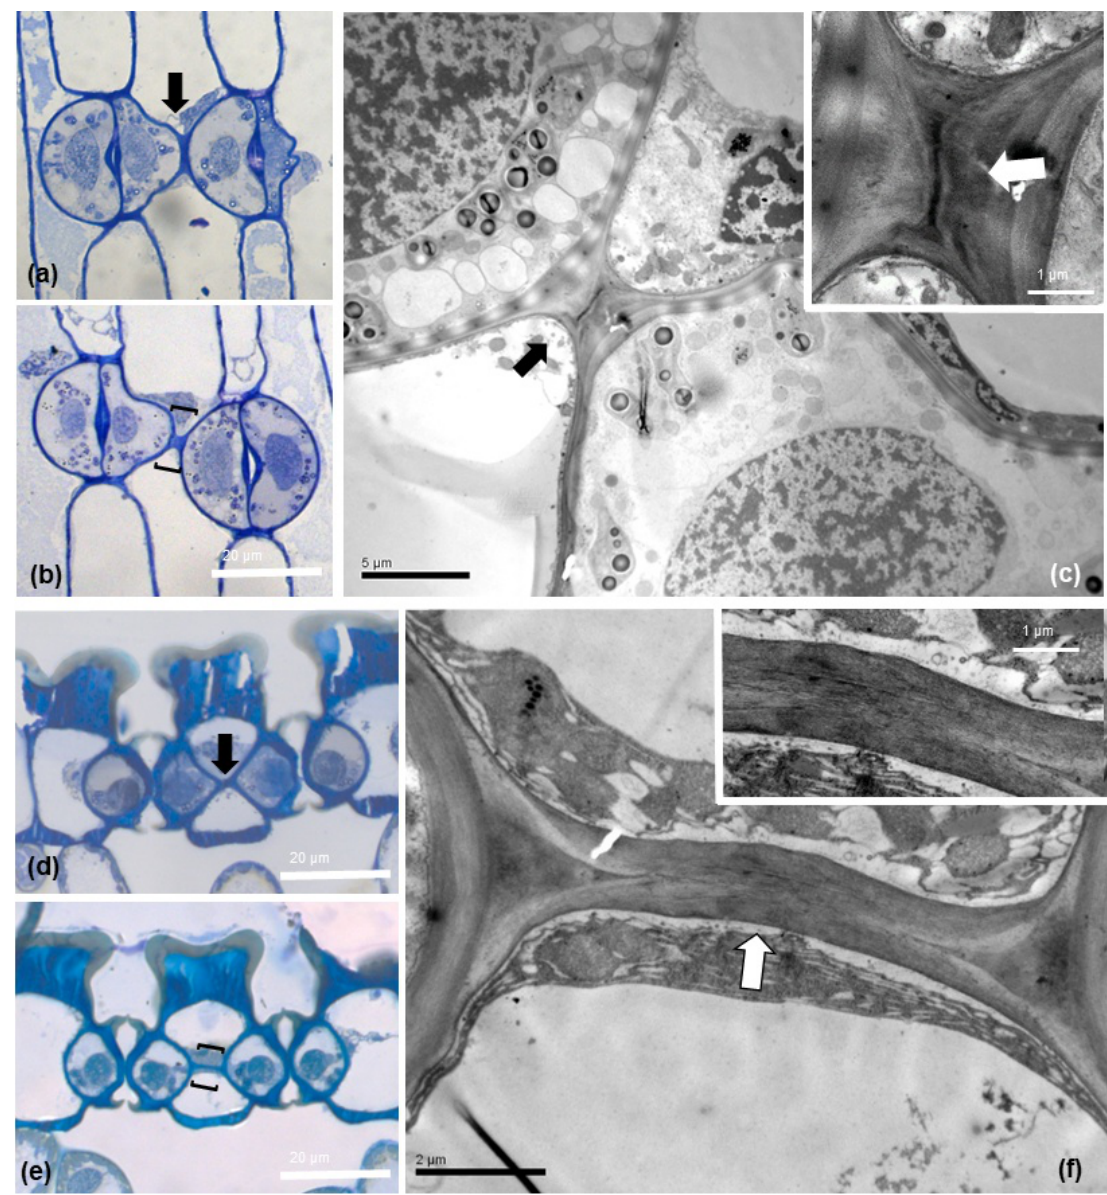
Figure 6. Light microscopy ( a , b , d , e ); toluidine blue O staining) and TEM ( c , f ) micrographs of paradermal ( a – c ) and transverse ( d – f ) sections of Pancratium maritimum leaves. The connection strand is indicated either by arrows ( a , c , d , f ) or brackets ( b , e ). In TEM micrographs ( c , f ) the cell wall texture of the depicted connections between adjacent stomata is identified. Insets show the areas indicated by the arrows at higher magnification. Scale bar as depicted on images.